Question: What form of chart is displayed?
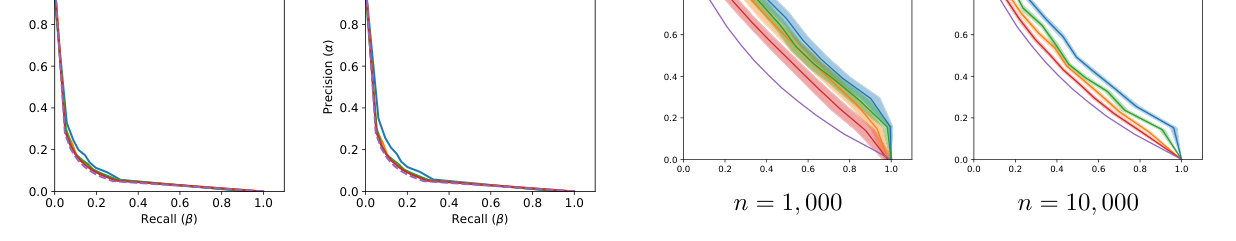
Answer: line